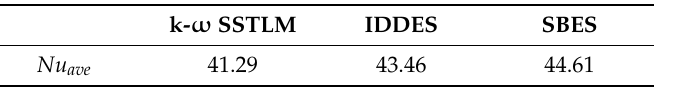
Table 2. Surface average Nusselt number.